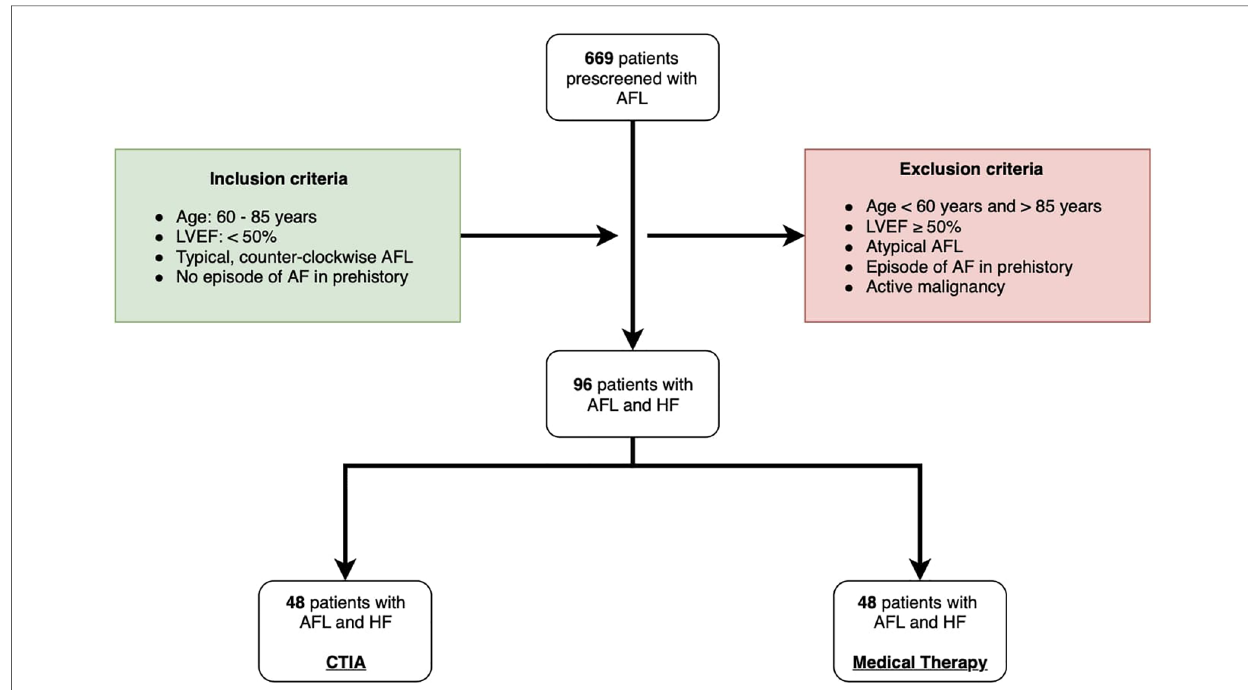
FIGURE 1 Flow chart of study design. AFL: atrial fl utter; LVEF: left ventricular ejection fraction; AF: atrial fi brillation; HF: heart failure; CTIA: cavotricuspid isthmus